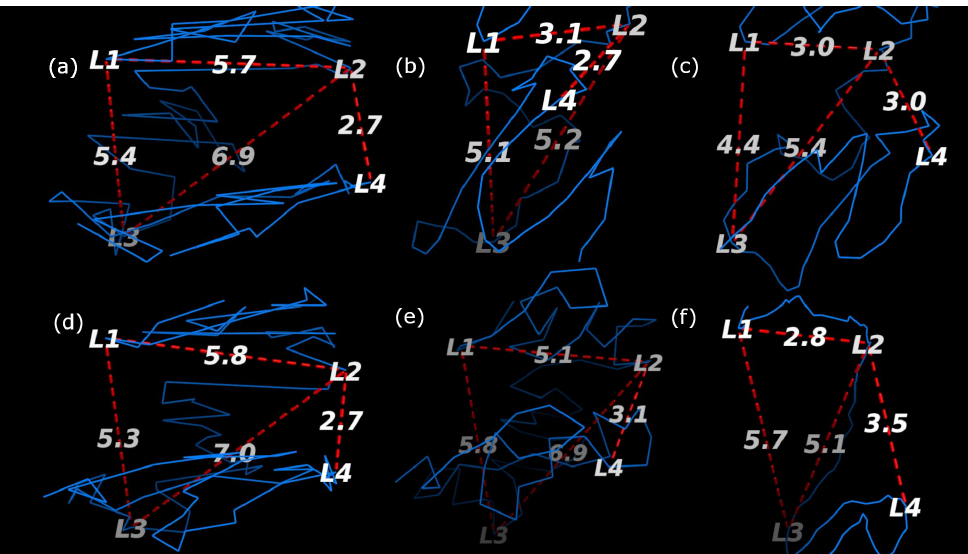
Figure 11. Fish Data Validation on Chromosome 14 from GM06990 litigated with Ncol at Resolution 1 mb. The blue line denotes the generated structure. The four probes (L1,L2,L3, and L4) from [5] are labeled on the chromosome, and the important distances between them have been labeled by red dashed lines. The methods used to generate each structure are as follows: ( a ) ChromeBat, ( b ) LorDG, ( c ) HSA, ( d ) 3DMax, ( e ) Chromosome3D, and ( f )